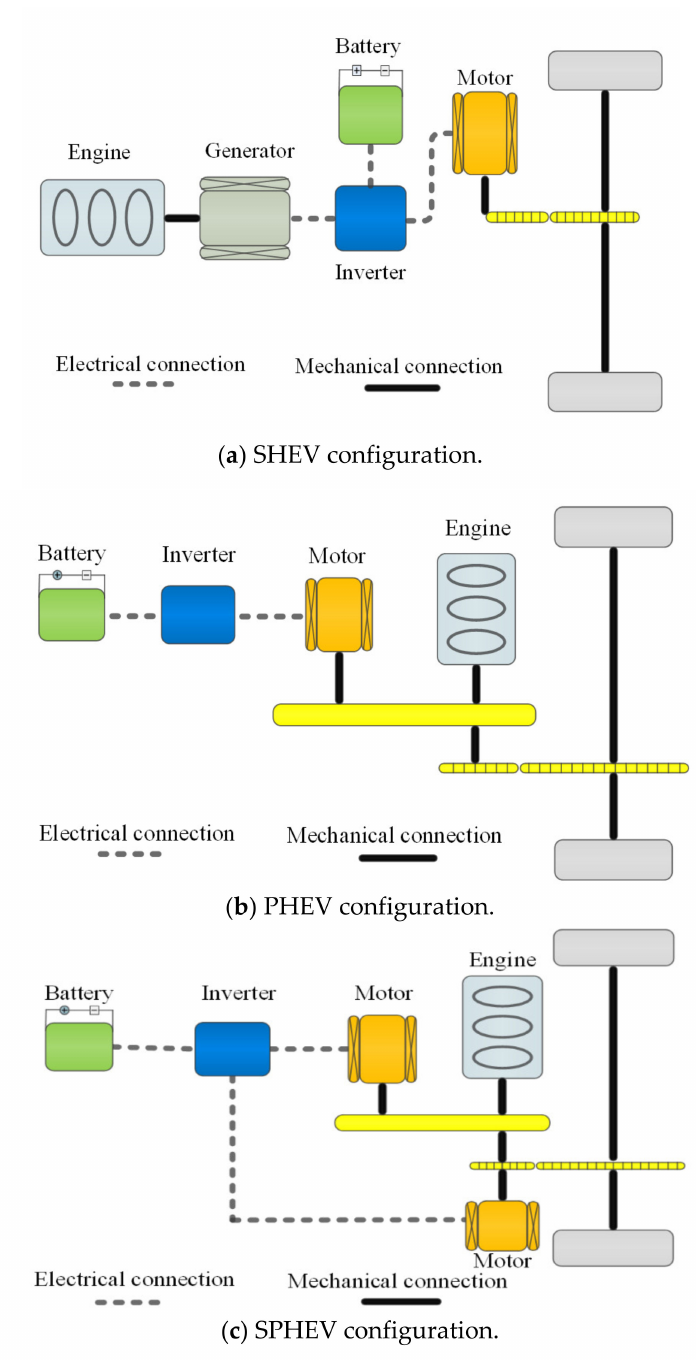
Figure 3. Classification of HEVs based on the components and configurations. SHEV: series hybrid electric vehicle; PHEV: parallel hybrid electric vehicle; and SPHEV: series parallel hybrid electric